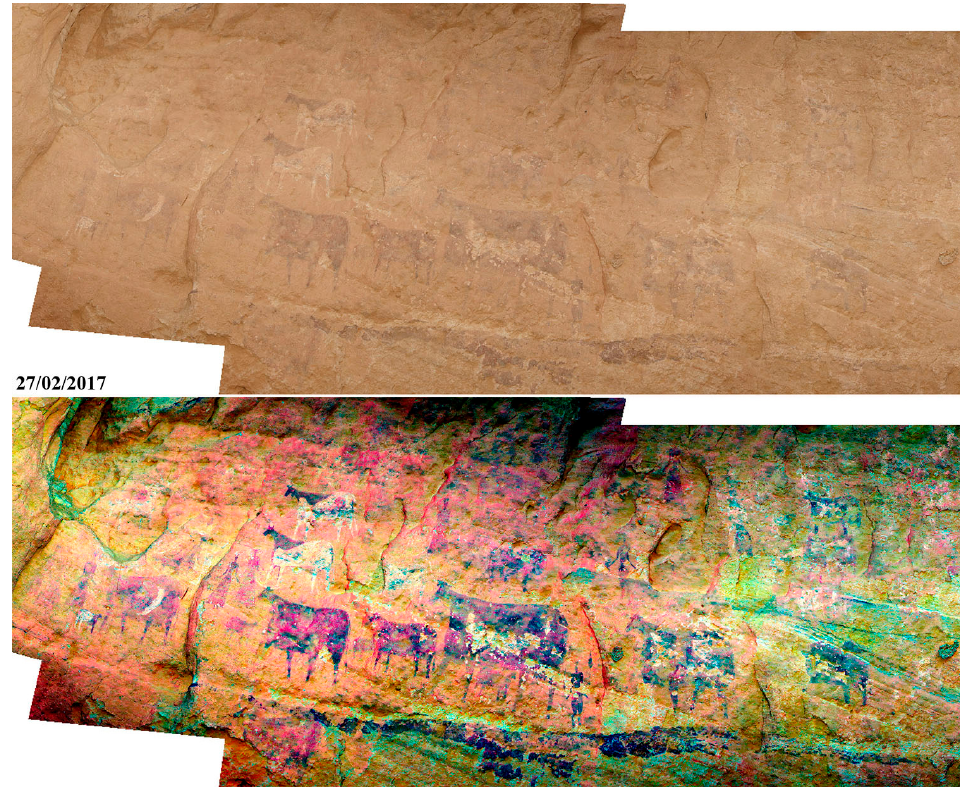
Figure 8. A large composition (P3) comprehending three women and two warriors, one armed with a spear, standing amid a cattle herd (Photo: Alessandro Menardi Noguera). The upper image is a photo-mosaic compiled by stitching three high-resolution pictures (on the lower half: enhanced version of the mosaic in DStretch LAB colour space).